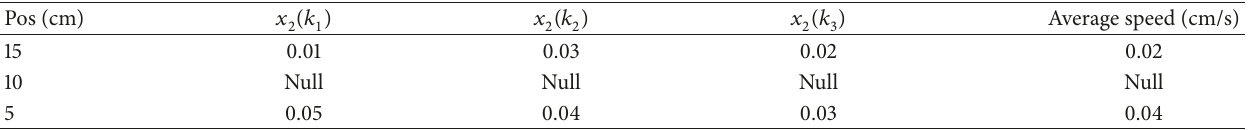
Table 2: Stiction table in instant 𝑘